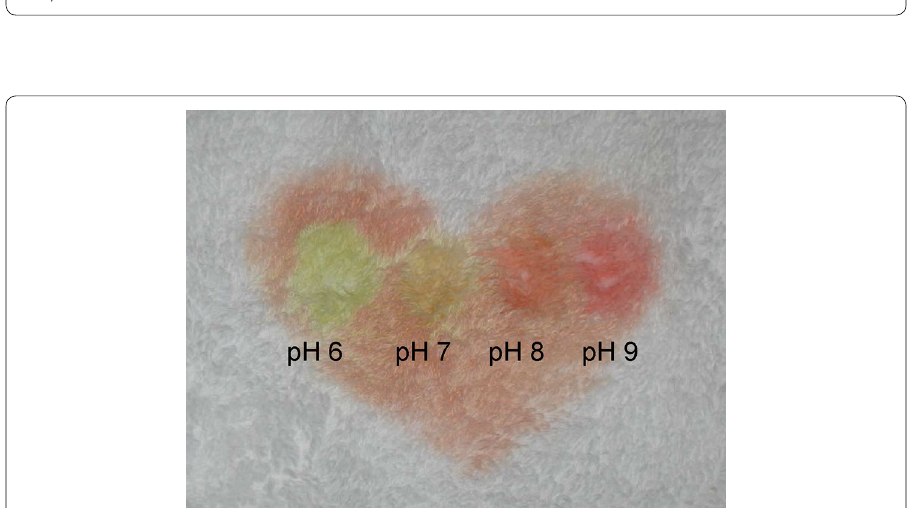
Fig. 3 Colour changes of the heart‑shaped indicator pattern on the washcloth IW3 in